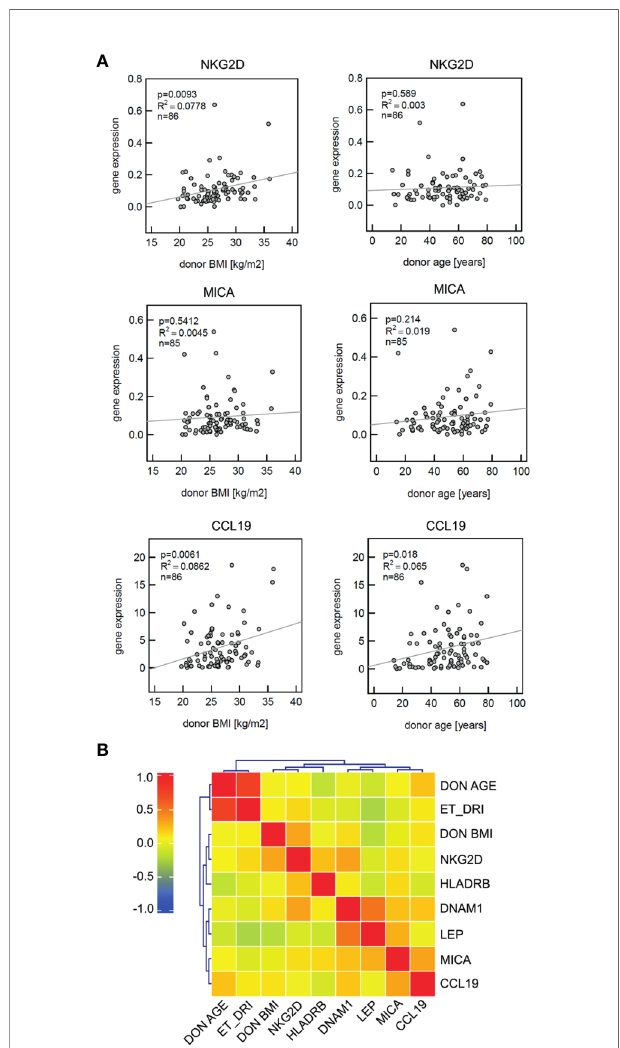
FIGURE 2 | Analysis of de fi ned markers for correlation with clinical parameters and coexpression pro fi le. (A) Gene expression of CCL19 signi fi cantly correlates with both donor BMI and donor age, NKG2D with donor BMI. Linear regression analysis was performed; the coef fi cient of determination (R 2 ) indicating the goodness-of- fi t and the p-values are provided. (B) Heat map visualizing the correlation matrix of gene expression levels in liver zero-hour biopsies. MICA expression patterns are not associated with donor age or donor BMI. Spearman ’ s rank correlation coef fi cient is presented according to the color scheme on the right. Hierarchical clustering was used to group genes with similar pro fi les as well as the risk factors donor BMI, donor age and Eurotransplant donor risk index